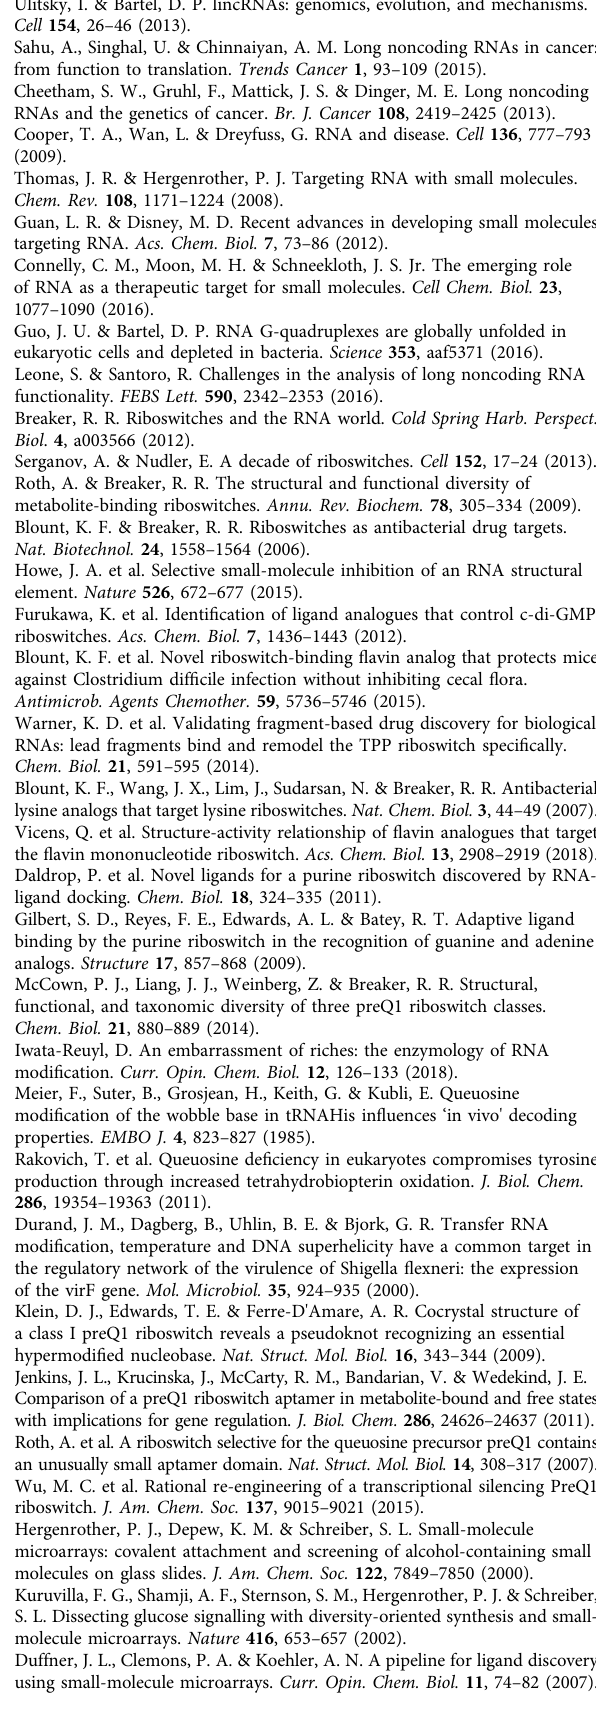
Supplementary Table 7. Molecular graphics were produced with PyMol (http:// www.pymol.org/). Stereo images are provided in Supplementary Figure 12 and 13. Single-round transcription termination assay . The transcription termination assays were carried out according to established protocols 53,54 with several mod- i fi cations. The DNA plasmid containing λ PR promoter and 26-nt C-less sequence followed by the Staphylococcus saprophyticus PreQ 1 riboswitch and its downstream sequence cloned into pIDTSMART-AMP was purchased from Integrated DNA Technologies. The DNA template was ampli fi ed by PCR from the plasmid using forward and reverse primers (Supplementary Table 6), and then was gel-extracted after agarose gel electrophoresis for puri fi cation. Halted transcription